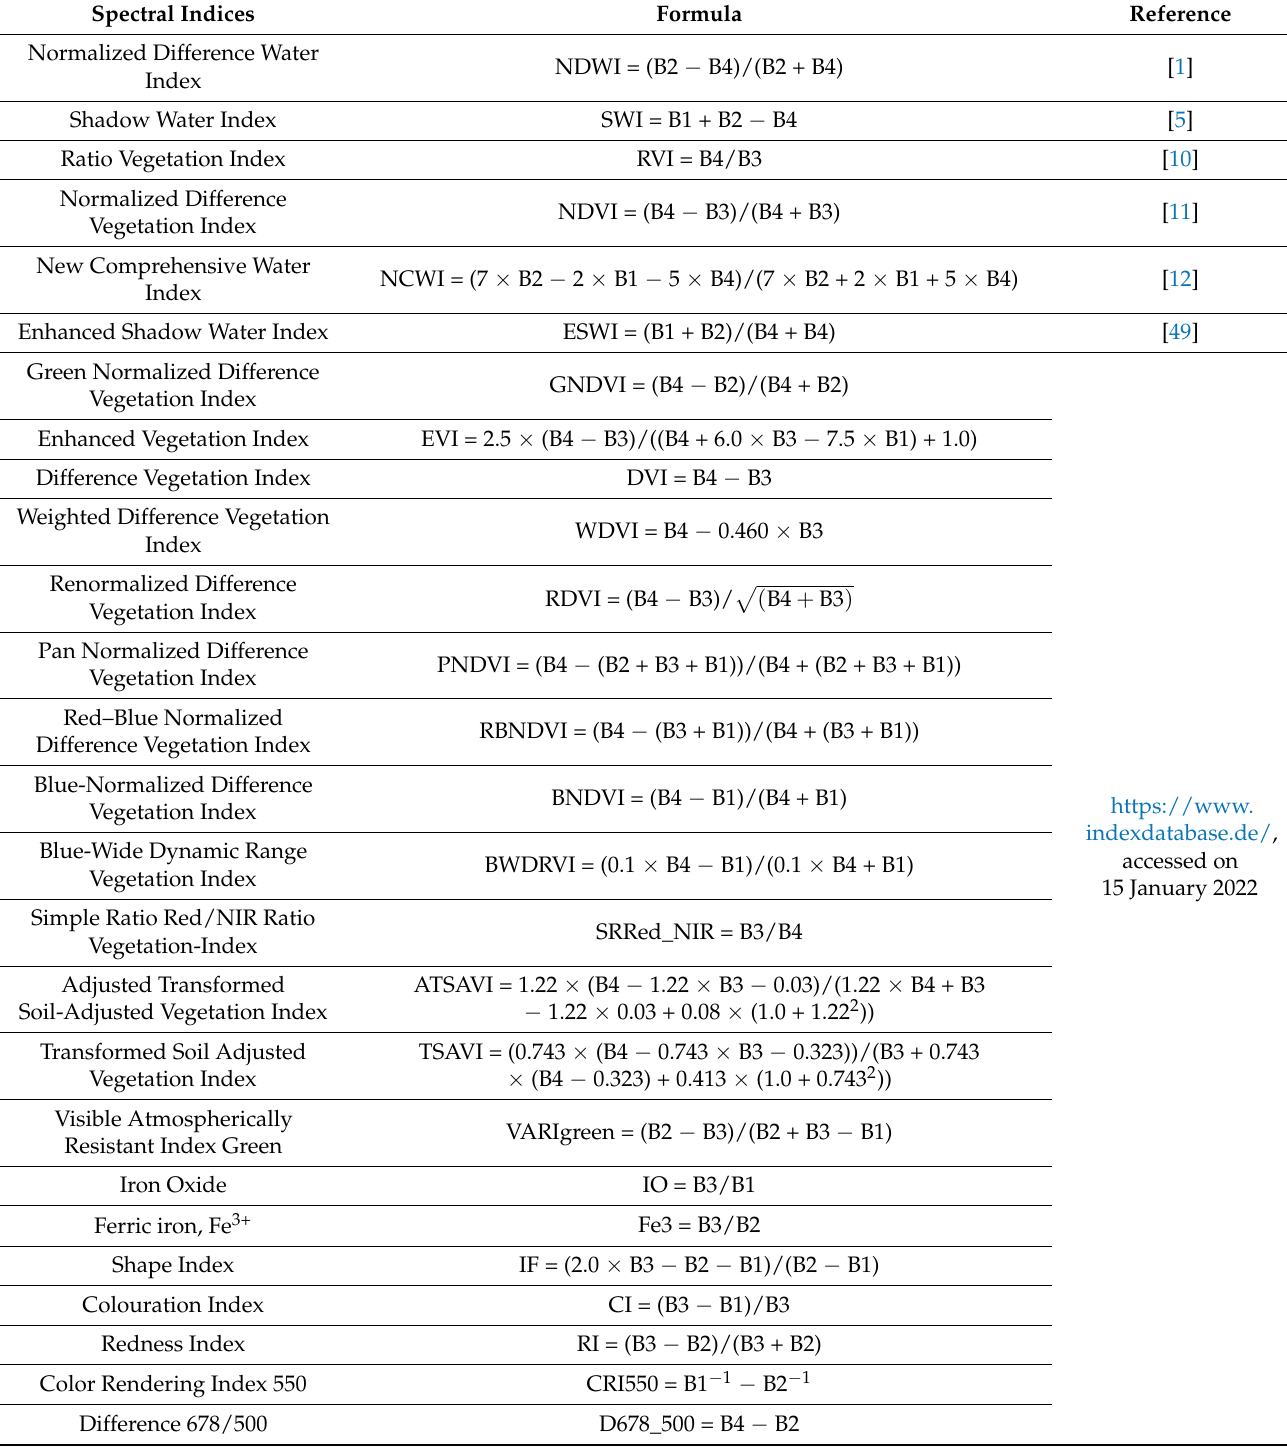
Table 2. Commonly used waterbody indices for 4-band high-resolution satellite